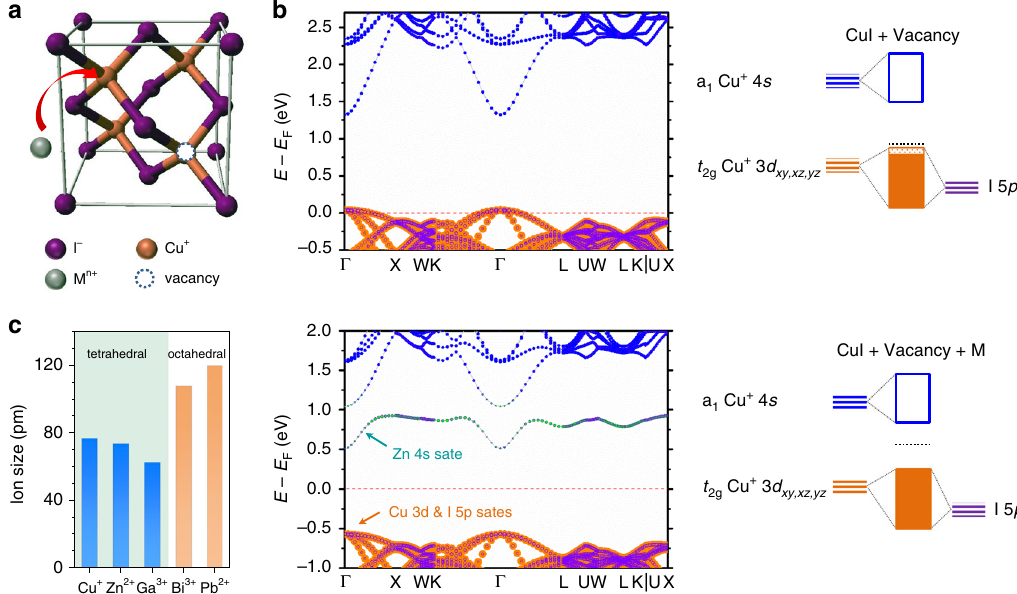
Fig. 1 DFT calculation. a Unit-cell of CuI and schematic of a Cu vacancy and doping at a Cu + site. b (Upper panel) Projected band structure of CuI with a Cu vacancy content of 3%; the Cu 3 d (orange), Cu 4 s (blue), and I 5 p (purple) states are shown. The corresponding schematic showing the orbital characteristics of the VBM and CBM is also presented. (Lower panel) Projected band structure of CuI with a Cu vacancy content of 3% and Zn 2 + substitutional doping; the Cu 3 d (orange), Cu 4 s (blue), I 5 p (purple), and Zn 4 s (green) states are shown. The corresponding schematic showing the orbital characteristics of the VBM and CBM is also presented. c Radii and typical coordination of candidate dopant